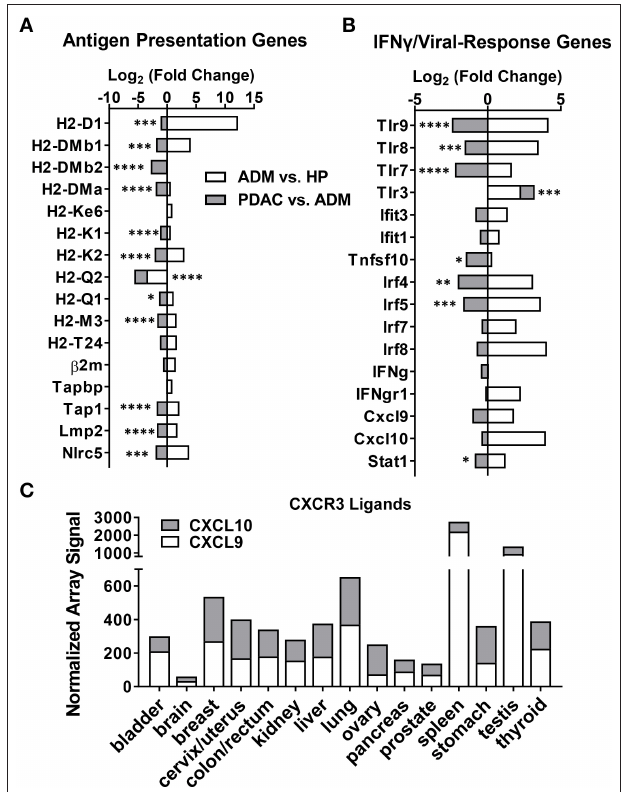
FIGURE 2 | Antigen presentation and viral response-associated genes decrease following malignant transformation to PDAC. Log 2 fold-change in gene expression from RNA-seq analysis, calculated as the ratio of ADM fold-change over HP (white) or PDAC fold-change over ADM (gray) ( n = 3 mice per group). (A) Fold-change in antigen presentation-related genes. (B) Fold-change in IFN- γ and innate immune-related genes. (C) Human microarray dataset (E-GEOD-2019) was analyzed for signal for CXCL9 and CXCL10 in various cancer types. p -values shown are for significance in fold change of PDAC over ADM. * p < 0.05, ** p < 0.01, *** p < 0.001, **** p <